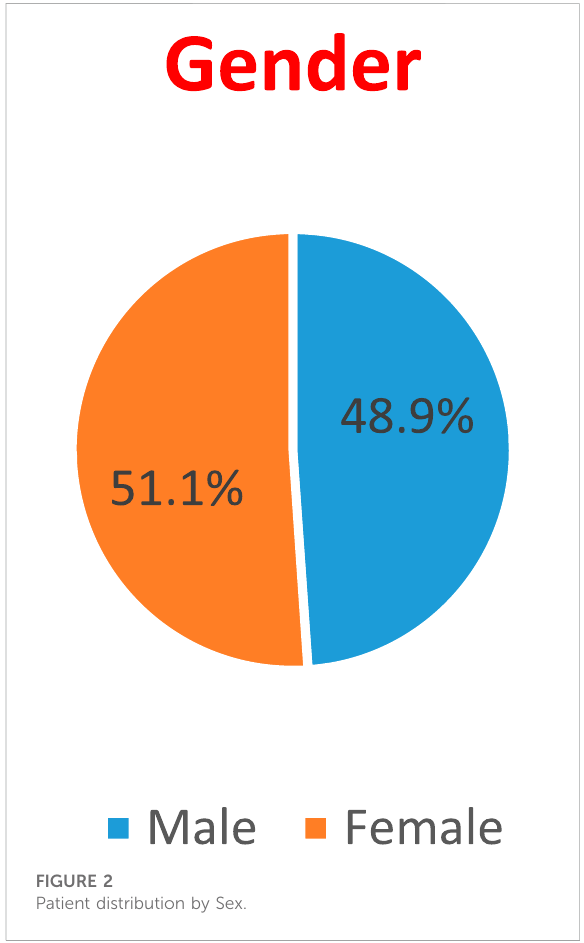
FIGURE 2 Patient distribution by Sex.